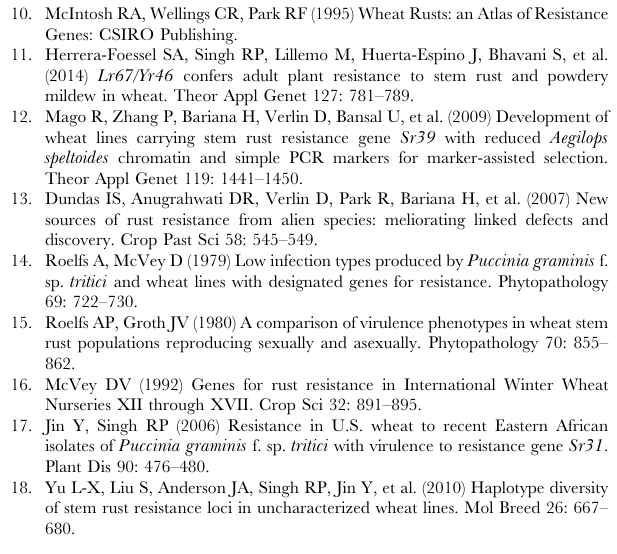
Table S1 Linear alignment of neighbor-joining tree, rust rating data, significant positive markers, positive alleles ( P , 0.001), and two most significant negative alleles. Table S2 List of 271 markers, assigned chromosome, and number of alleles detected across 174 U.S. wheat accessions. Table S3 Conversions of Stakman infection types to a linear